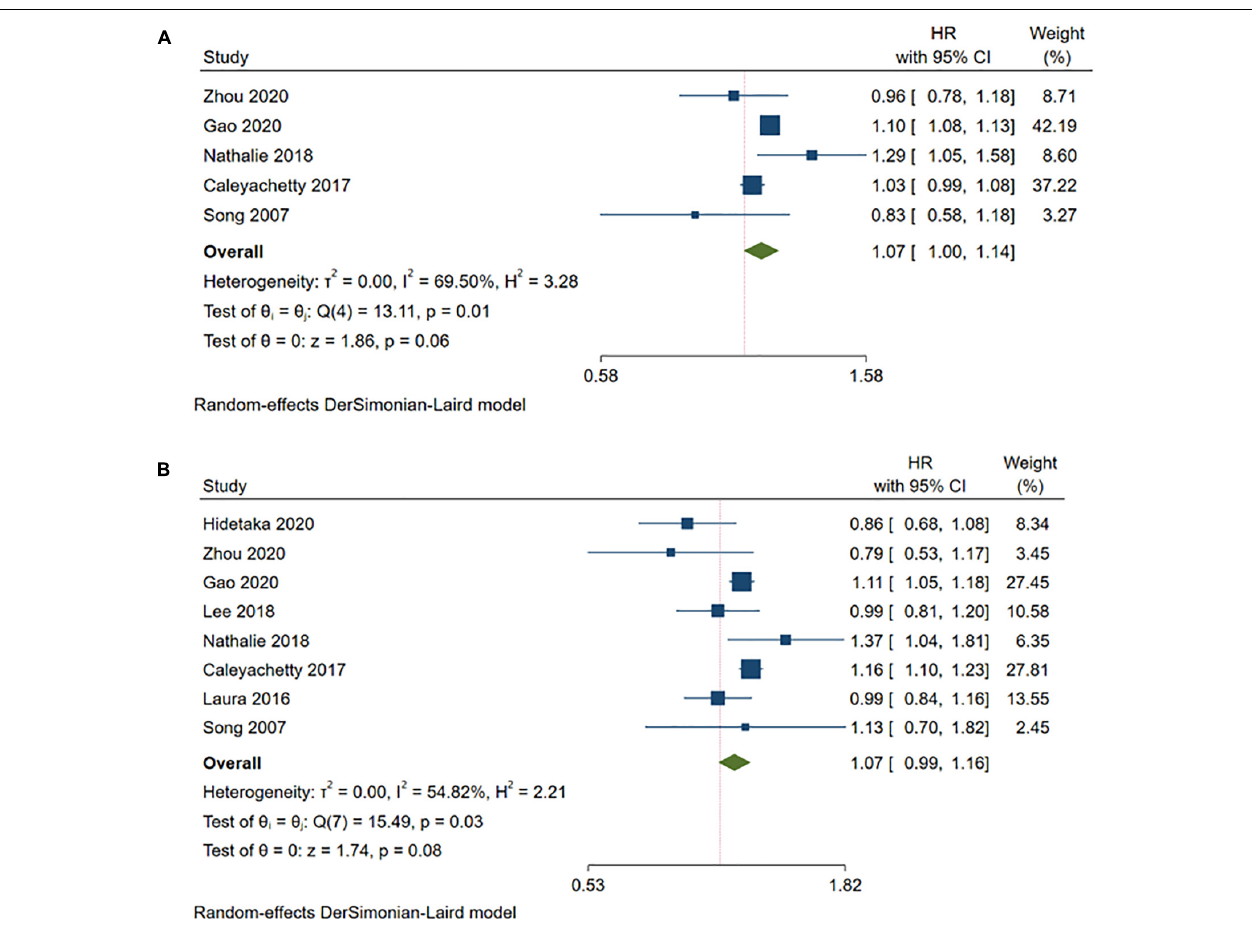
FIGURE 2 | Meta-analysis of the risk of stroke in the MHOW/MHO phenotypes compared with the MHNW phenotypes. (A) MHOW phenotypes; (B) MHO phenotypes. MHNW, metabolically healthy normal weight; MHOW, metabolically healthy overweight; MHO, metabolically healthy obese; MUNW, metabolically unhealthy normal weight; MUOW, metabolically unhealthy overweight; MUO, metabolically unhealthy obese.